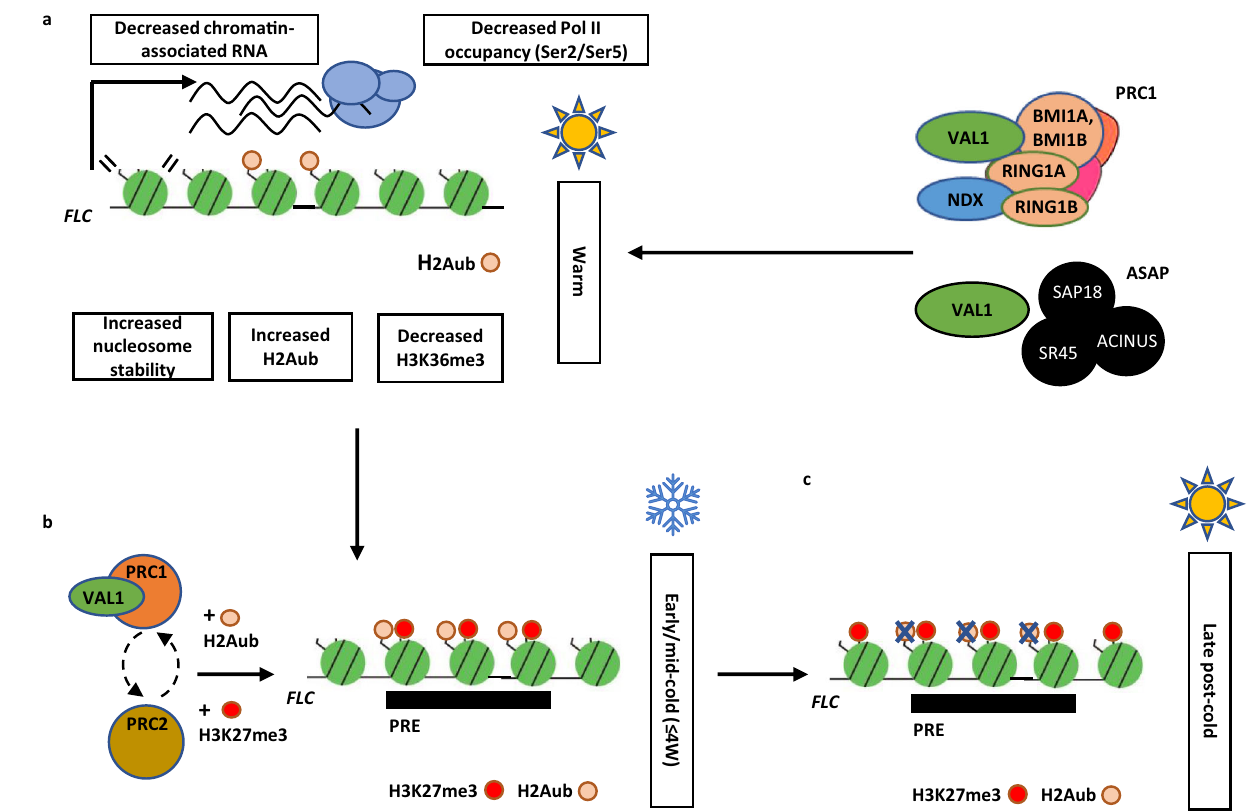
Fig. 7 | Functional relationship of ASAP, PRC1, and PRC2 (H3K27me3) in FLC regulation. a ASAP and PRC1 act as co-repressors that regulate FLC chromatin features and downregulate FLC expression in warm. b Upon shift to cold, PRC1- mediated H2Aub accumulates at FLC PRE along with H3K27me3 through the coordinated action of VAL1, PRC1, and PRC2. H2Aub and H3K27me3 are present at